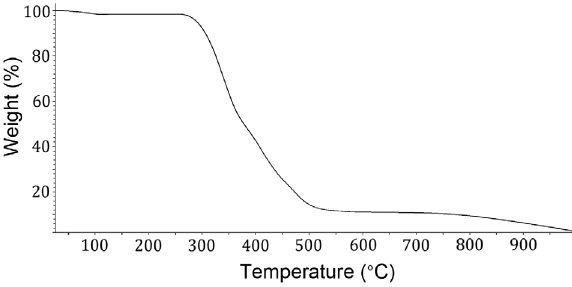
chtc - )]H chtc - ·H O ( 1 2 2 2